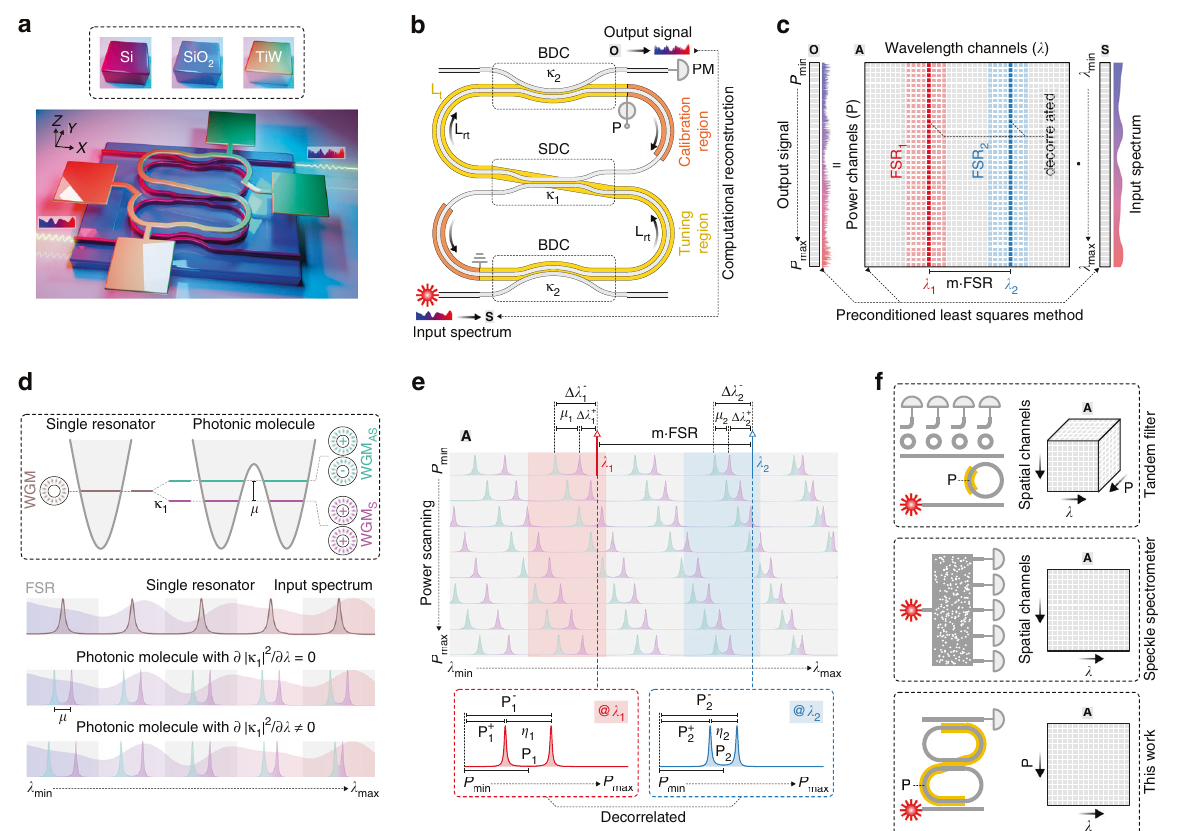
Fig. 1 Conceptual illustration of the spectrometer. a 3D view of the spectrometer. b Schematic layout of the spectrometer. The proposed design is a photonic molecule consisting of two identical micro-ring resonators (MRR) that are synchronously tuned over a single free-spectral range (FSR). By linearly sweeping the applied heating power ( P ), the input spectrum ( S ) is scanned while the output signal ( O ) is recorded. c Reconstruction principle. The unknown S and recorded O are related by a transmission matrix ( A ). S can be reconstructed from O by utilizing the iterative optimization to solve a linear inverse problem if all the wavelength channels of A are decorrelated. d Dispersion engineering. For a single MRR, the transmission responses at different FSRs are indistinguishable. For a photonic molecule, the mode-splitting effect results in a symmetric mode (WGM S ) and an anti-symmetric mode (WGM AS ) at each FSR. If the inter-resonator coupling strength (| κ 1 | 2 ) is dispersive, the splitting strength ( μ ) will vary with wavelengths. e Decorrelation mechanism. The scanning trace at each wavelength ( λ i ) features a pair of peaks with the mean location of P i and spacing of η i . Owing to the dispersion of μ , η 1 , and η 2 are distinct even for the wavelengths with λ 2 = λ 1 + m ∙ FSR (where m is an integer), thereby enabling the identi fi cation of each λ i from P i and η i . f Comparison of various types of